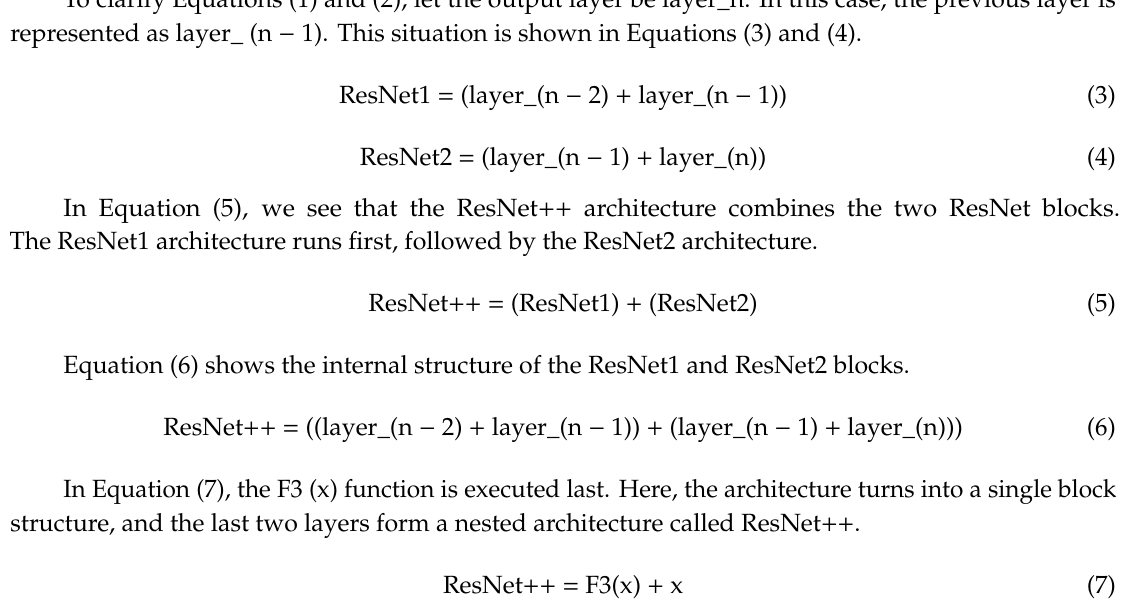
Figure 8. ResNet ++ Figure 8. ResNet++ architecture.